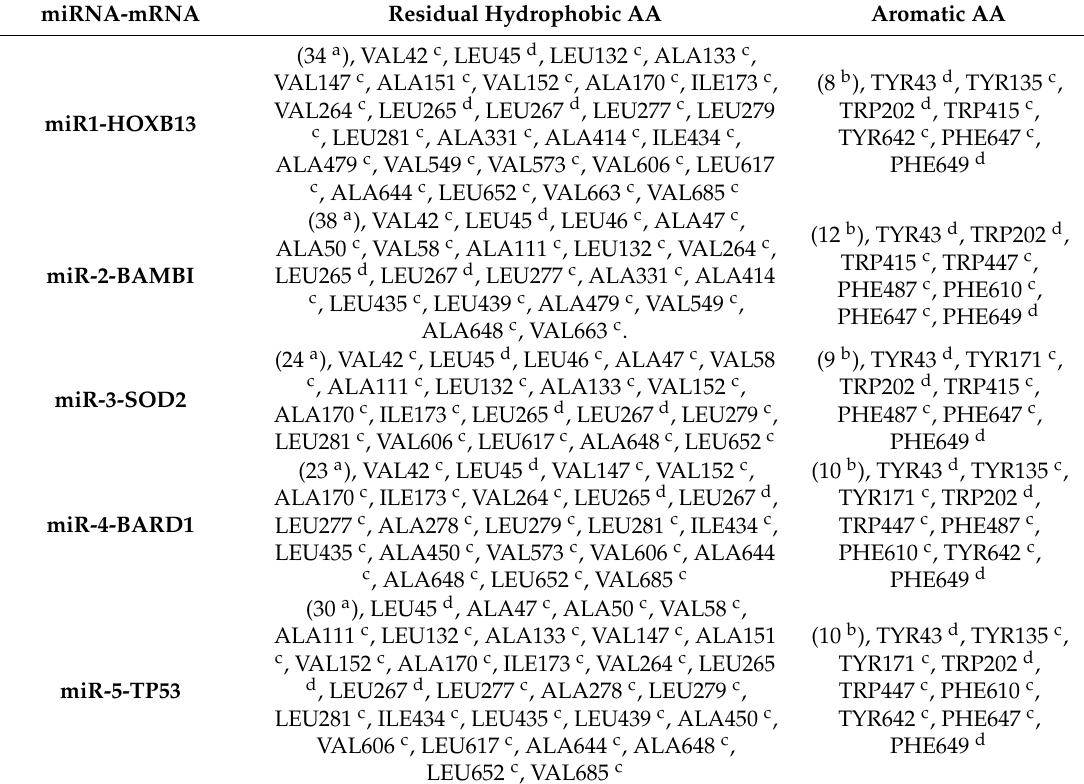
Table 10. Amino acid residues of the binding pocket of the argonaute protein involved in the molecular interaction with the microRNA-mRNA complex (3.5